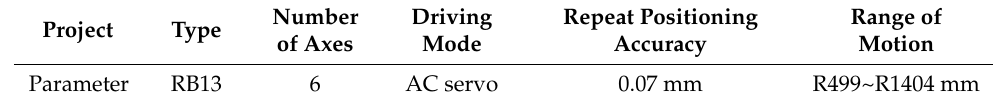
Table 3. Parameters of the industrial robot with the model.